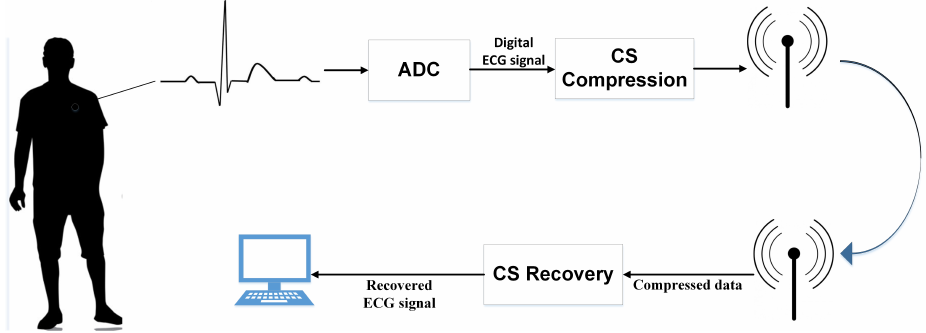
Figure 1. Typical compressed sensing (CS)-based ECG wireless telemonitoring